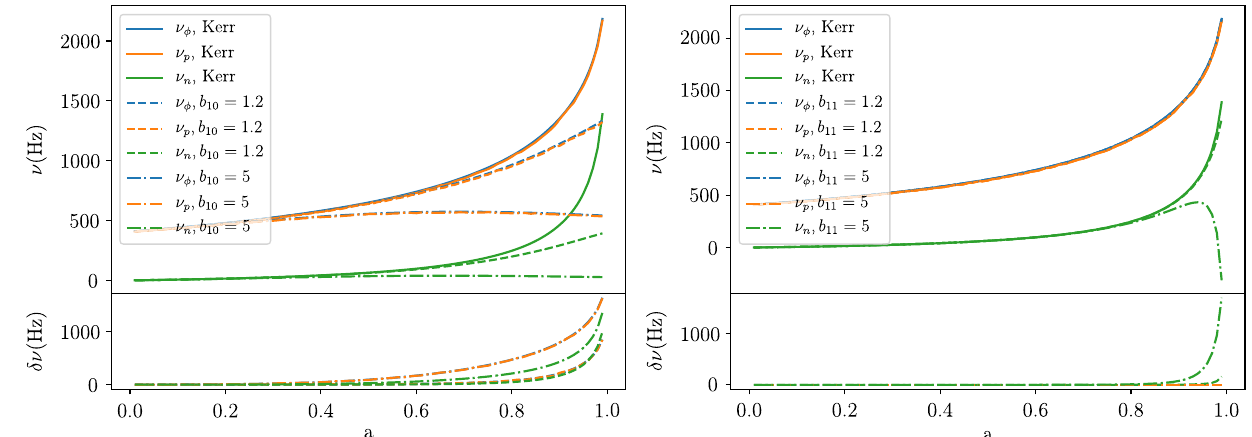
Fig. 5 Dependence of the QPO frequencies at ISCO on the BH spin for a GB metric with given b 10 (left panels) and b 11 (right panels), respectively. Top panels show the resulting QPO frequencies for b 10 or b 11 = 1 , 1 . 2, and 5, respectively, while bottom panels show QPO